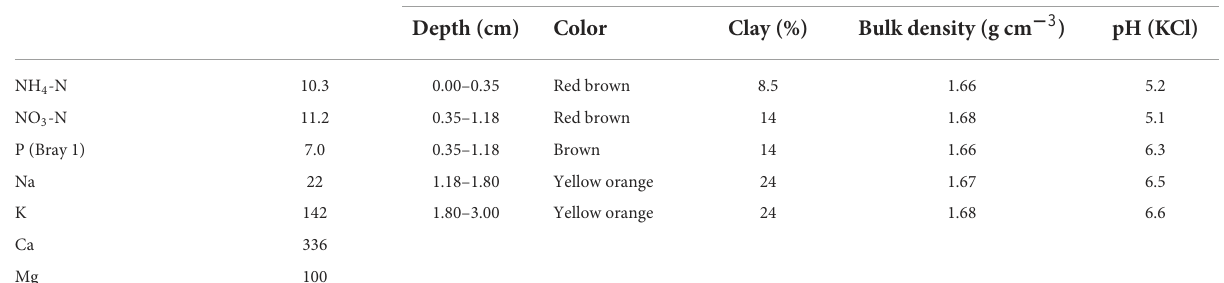
TABLE 1 Soil physical and chemical properties at the experimental site.